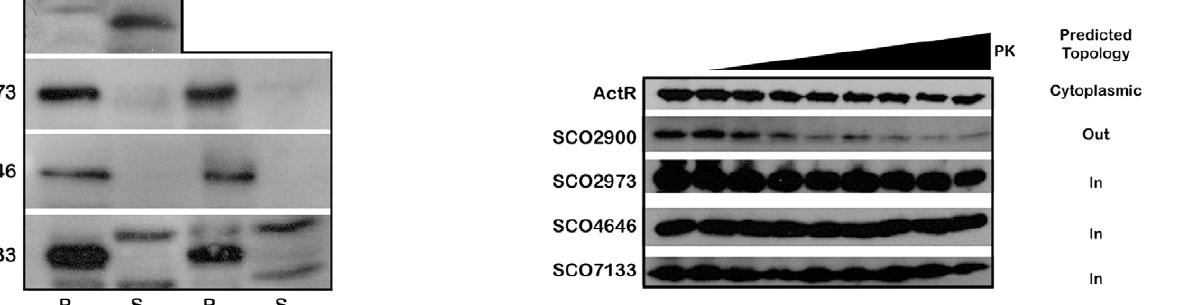
Figure 4. Localization of eGFP tail anchor fusions. Putative tail anchor transmembrane domains from SCO2973, SCO4646 and SCO7133 were fused to the C-terminus of the cytoplasmic protein eGFP and localization to the pellet (P) and supernatant (S) fractions was determined in the presence of either sucrose ( 2 ) or carbonate ( + ). Unfused eGFP is shown for comparison. Localization was detected by Western blot analysis against eGFP.